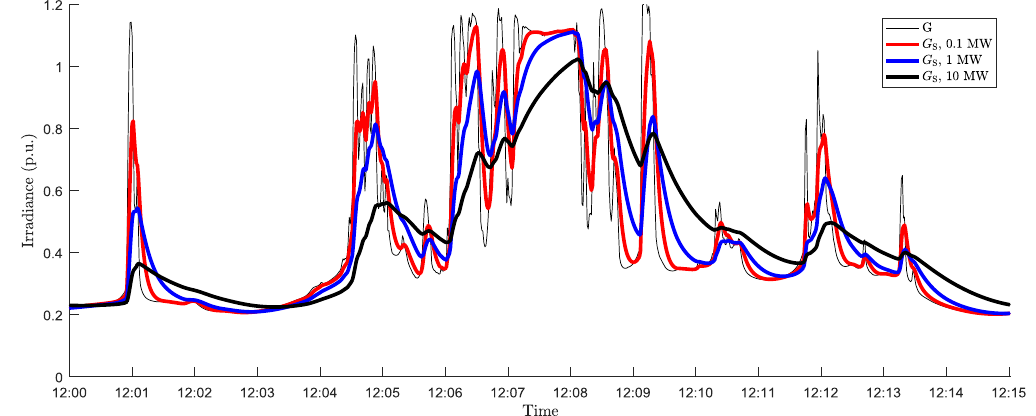
Figure 2. Unfiltered measured irradiance and effective irradiances of 0.1, 1 and 10 MW PV generators on the 23rd of April. Irradiance values have been normalized to STC irradiance.